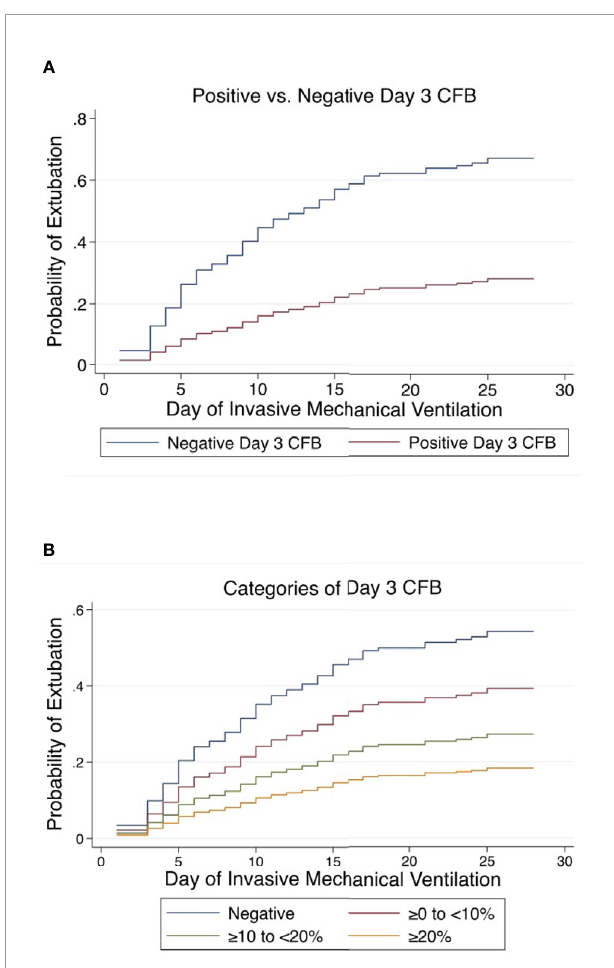
FIGURE 5 | Cumulative incidence functions for extubation at 28 days. Competing risk = PICU mortality (A) Positive vs. Negative Day 3 Cumulative Fluid Balance. (B) Categories of Day 3 Cumulative Fluid Balance. CFB, Cumulative Fluid